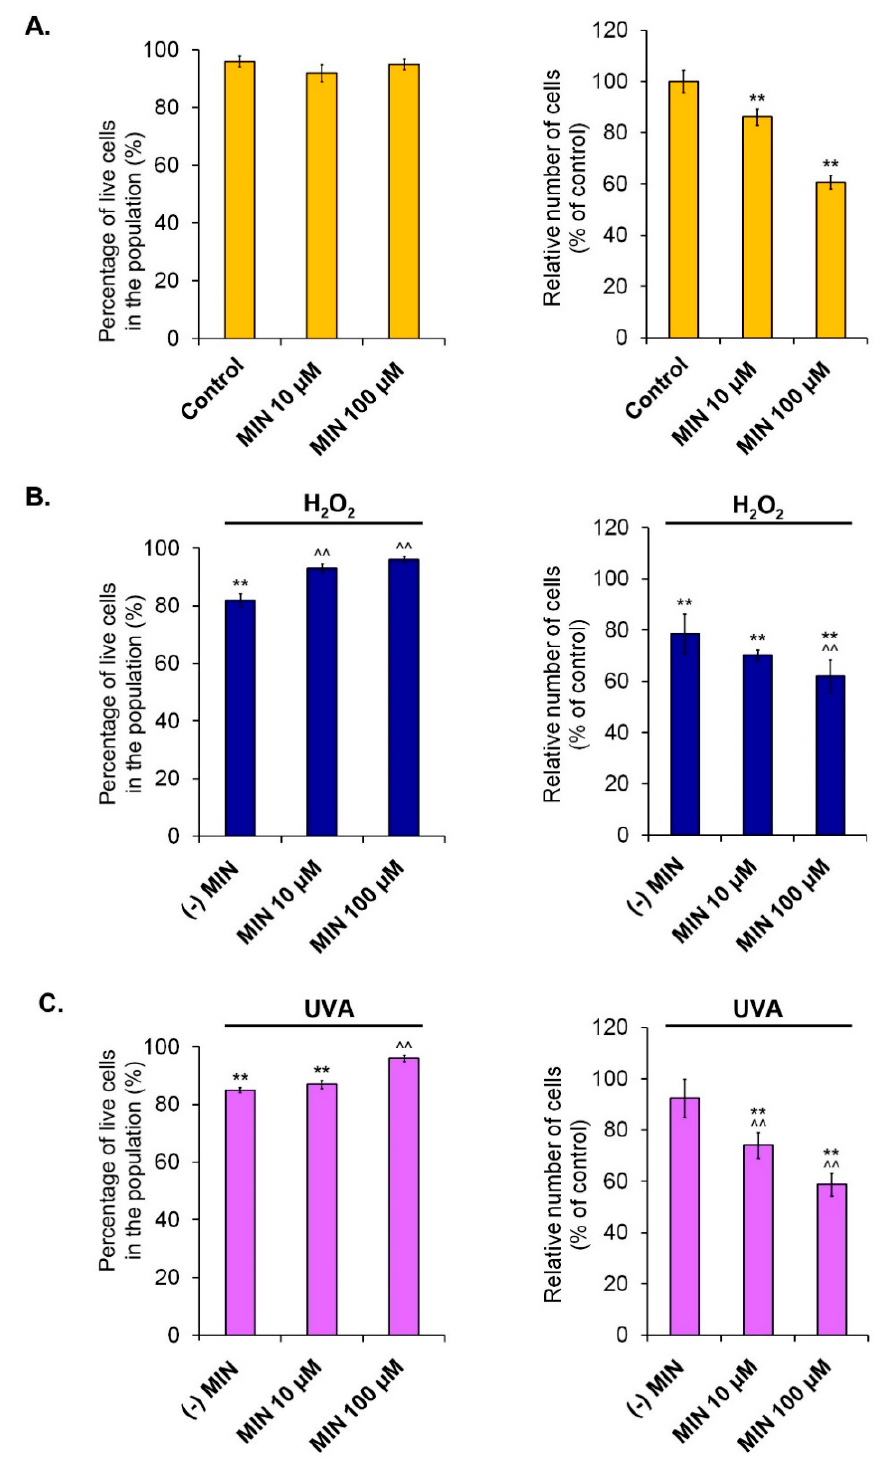
Figure 3. The influence of minocycline on cell number and the viability of: normal human melanocytes ( A ), the melano- cytes treated with hydrogen peroxide ( B ), and the melanocytes exposed to UVA radiation ( C ). ** p < 0.005. vs. control; ^^ melanocytes ( A ), the melanocytes treated with hydrogen peroxide ( B ), and the melanocytes ex- p < 0.005. vs (-) MIN. posed to UVA radiation ( C ). ** p < 0.005. vs. control; ˆˆ p < 0.005. vs. (-)